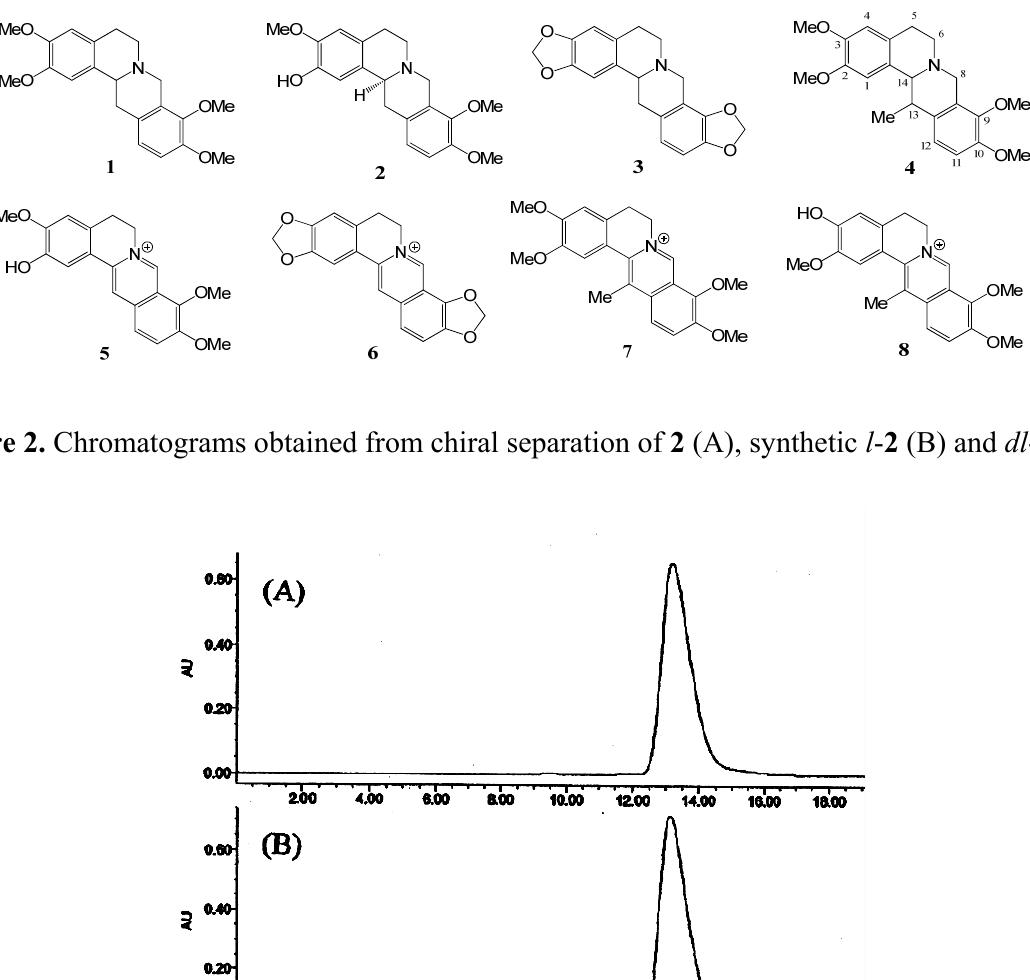
Figure 1. Isoquinoline alkaloids isolated from C. yanhusuo.